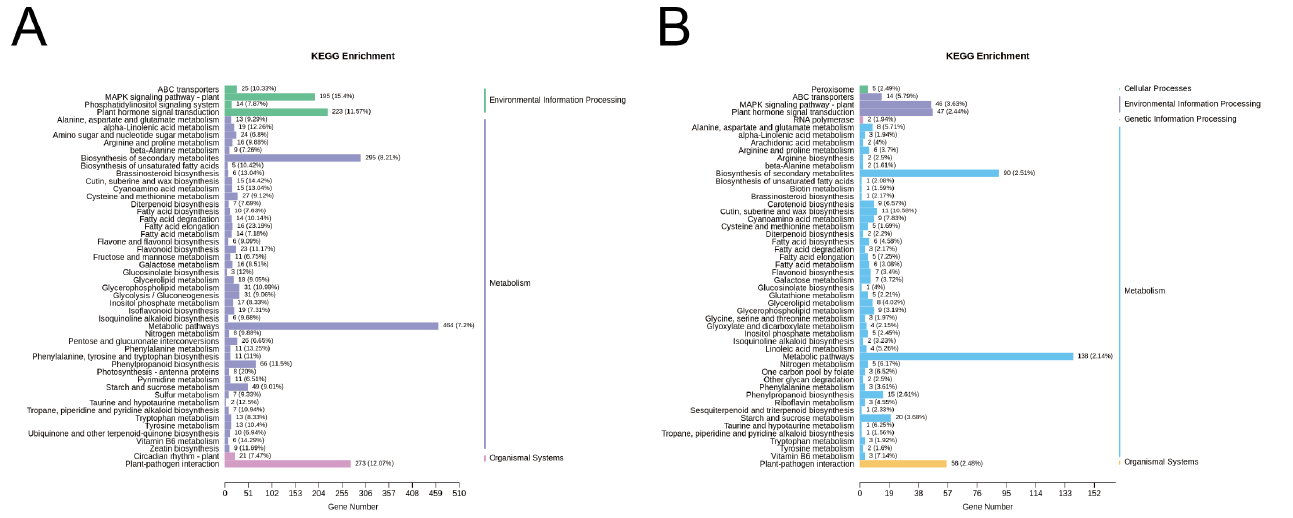
Figure 7. KEGG pathway enrichment of induced DEGs. ( A ) KEGG pathway enrichment of DEGs between EV vs. OE. ( B ) KEGG pathway enrichment of DEGs between EV vs. STTM.